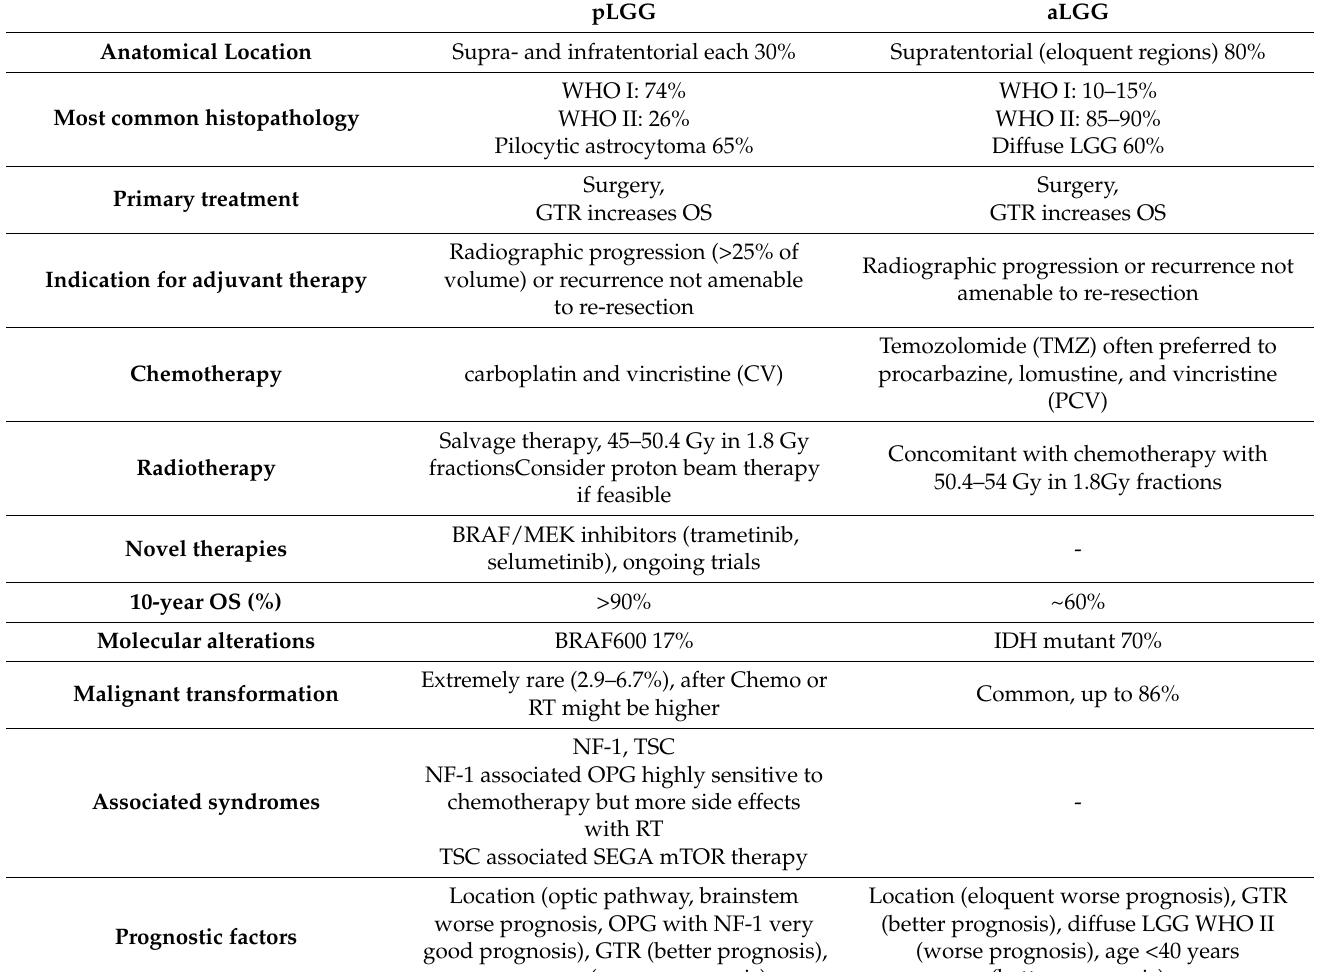
Table 1. Characteristics of pediatric and adult